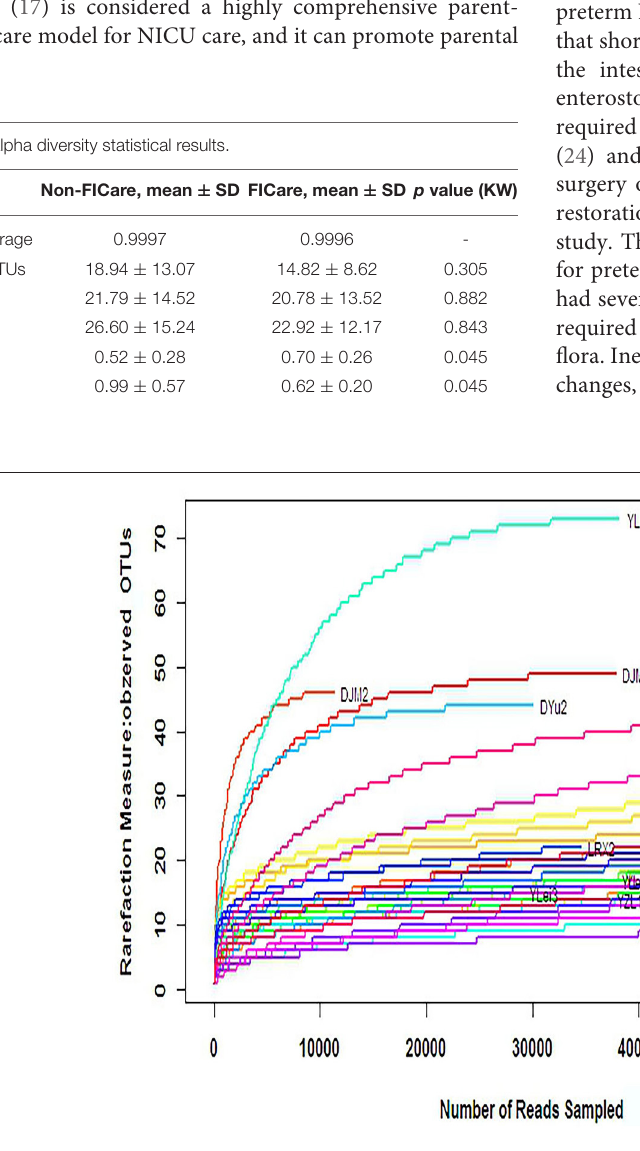
FIGURE 8 | The rarefaction curve of